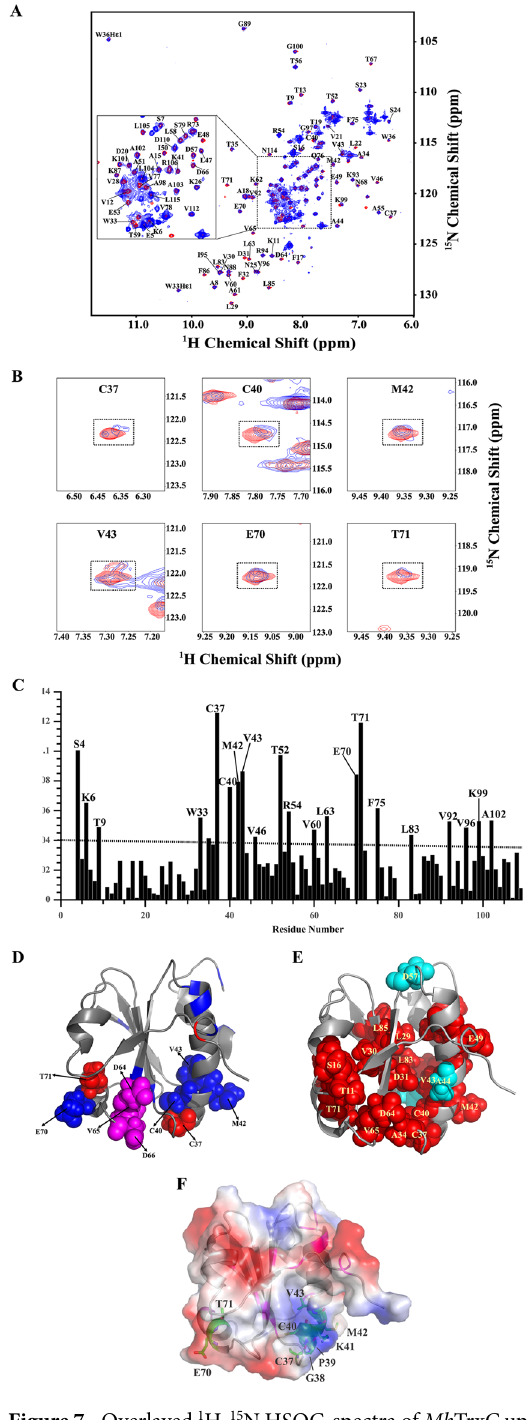
Figure 7. Overlayed 1 H- 15 N HSQC-spectra of Mb TrxC upon titration with Mb AhpC at a molar ratio 1:2. ( A ) Superimposition of the 1 H- 15 N HSQC spectrum of Mb TrxC alone ( red ) and in the presence of Mb AhpC ( blue ). 1 H- 15 N HSQC-spectra were obtained on a Bruker avance 700 MHz NMR spectrometer at 298 K. Backbone resonance assignments (based on the BMRB, accession code: 17242) 23 are indicated in a one-letter amino acid code and sequence number. ( B ) Selected sections for some residues show cross-peaks undergoing significant chemical shift perturbation. ( C ) Molecular interaction between Mb TrxC and Mb AhpC. A plot of chemical shift perturbations after addition of Mb AhpC into Mb TrxC at a molar ratio 1:2. Differences of chemical shifts were calculated using the following formula, Δδ = [( 1 H free − 1 H bound ) 2 + ( 15 N free − 15 N bound ) 2 )] 1/2 . ( D ) Ribbon representation of Mb TrxC mapped by CSP results; the residues having CSP more than 0.1 are represented in red , while those showing CSP between 0.05 and 0.1 are shown in blue . Candidates for interacting residues with Mb AhpC are represented as sphere model and are labeled. Additional candidates (D64-D66) based on the linewidth analysis are represented as magenta sphere. ( E ) Ribbon and sphere representation of Mb